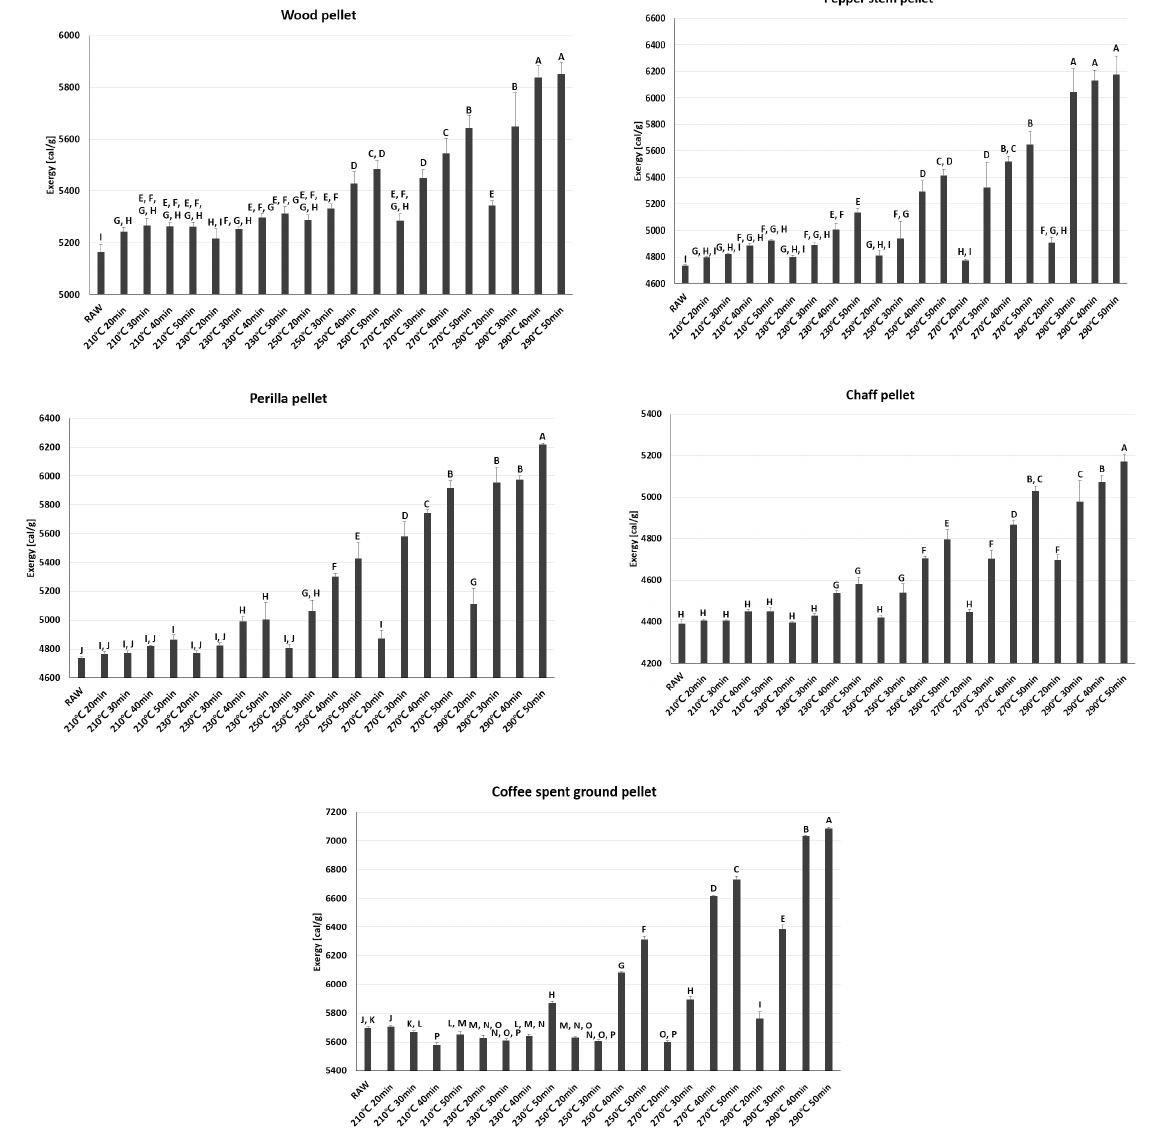
Figure 9. Exergy di ff erence of each torrefied Figure 9. Exergy difference of each torrefied pellet. Figure 9. Exergy difference of each torrefied pellet.